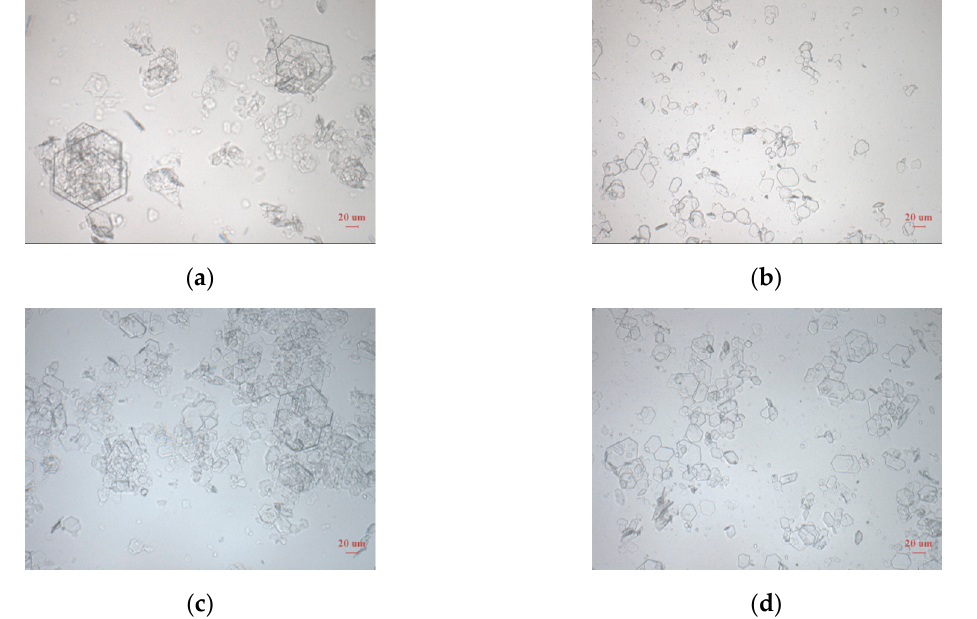
Figure 18. Crystal morphology of LCZ696 during the co-crystallization: ( a ) 350 rpm, ( b ) 500 rpm; ( c ) 0.011 g, ( d ) 0.044